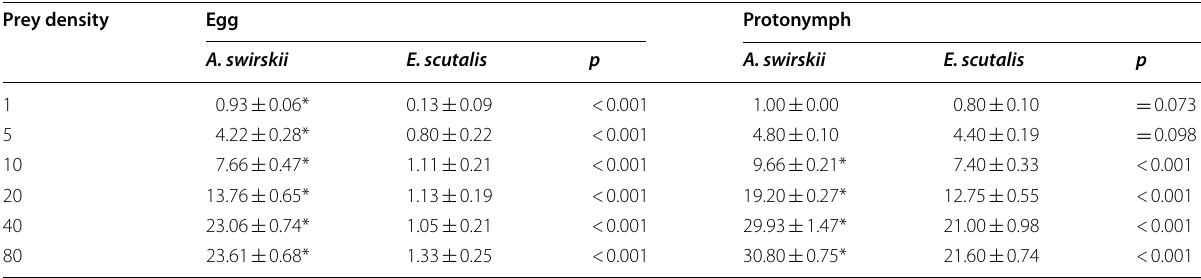
*Significant differences between each pair of prey consumption by A . swirskii and E . scutalis for the same prey densities (Mann–Whitney U test; t test)